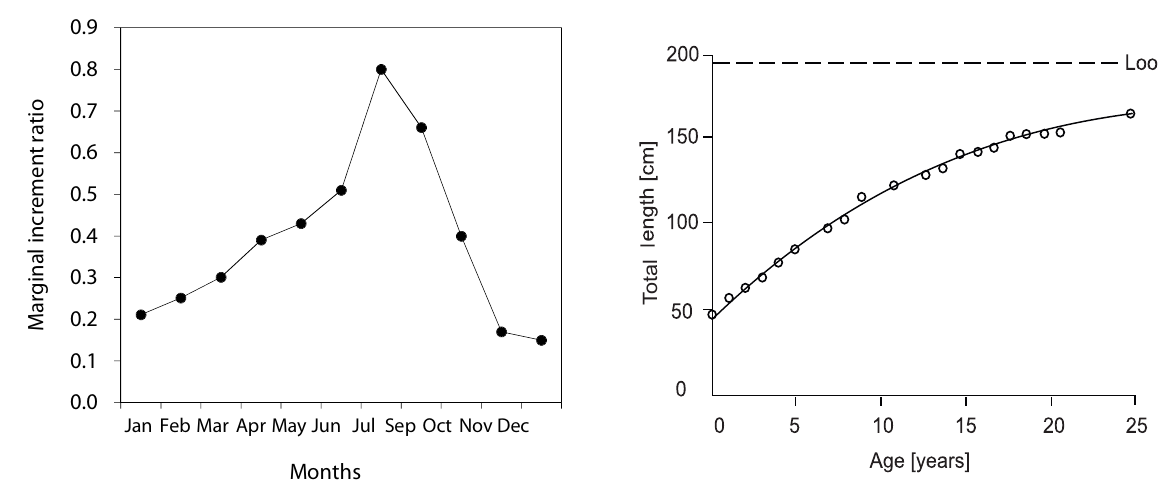
Fig. 6. Age bias plot between readers for all age estimates for Mustelus mustelus from the Gulf of Iskenderun, north-eastern Mediterranean Sea; the numbers show repeated annuli counts